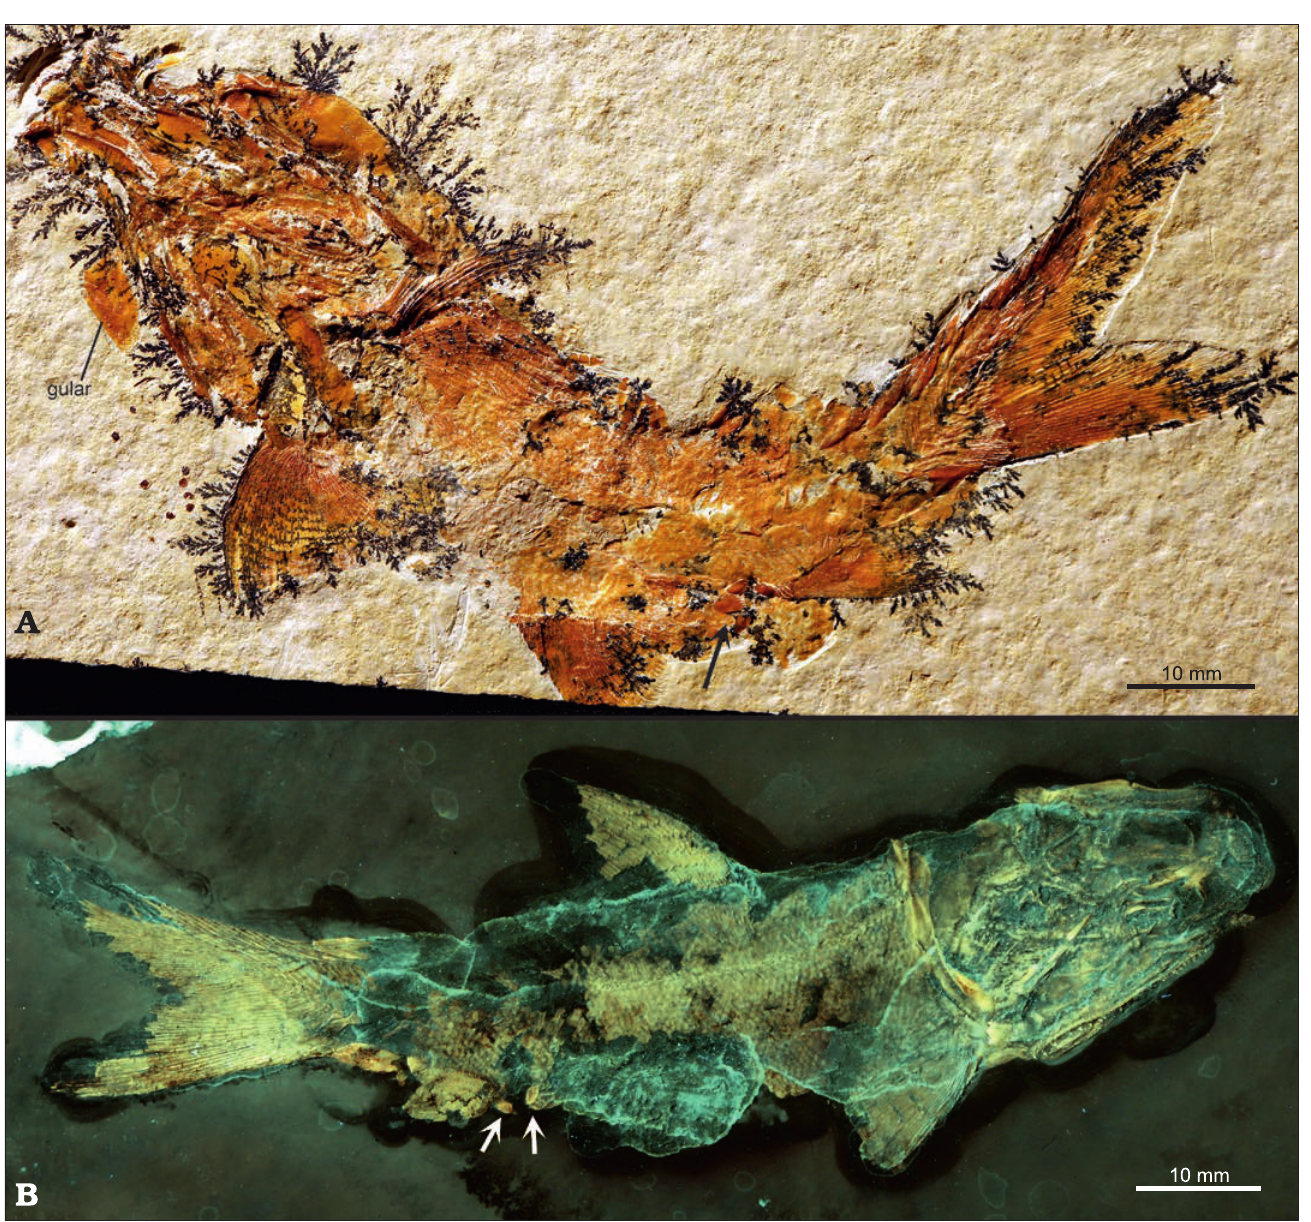
Fig. 3. Chondrostean fish Coccolepis bucklandi Agassiz, 1843 from the Tithonian, Upper Jurassic of the Solnhofen Lagerstätte, Bavaria, Germany. A . JME- SOS3445, the skull and anterior part of the body are preserved in ventral view. The specimen is twisted at the pelvic fins and the posterior part of the body is preserved in left lateral view (TL = 120 mm). B . JME-SOS3382 (photographed under UV-light), the body is preserved in right lateral view; the skull is slightly twisted and preserved in dorsolateral view (TL = 100 mm). Arrows point to preanal scutes. A, B, Photographs courtesy of Andreas Hecker